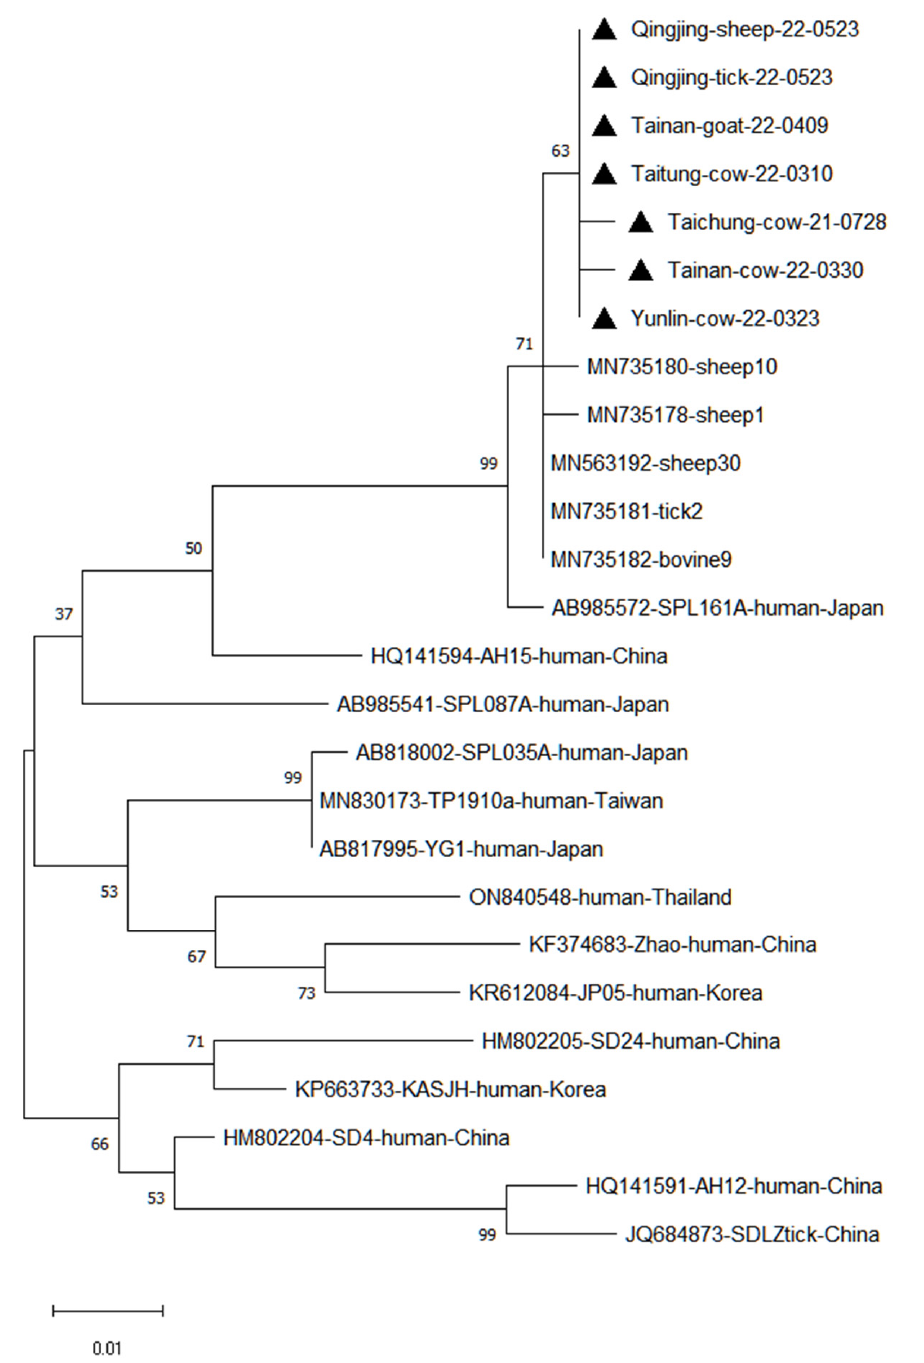
Figure 4. Phylogenetic analysis of the partial S segment of SFTSV identified in Taiwan. In total, sequences of 7 positive samples (indicated as a black triangle) with higher RNA load were ampli- fied and further analyzed. Other representative viral strains were presented with their accession numbers and also the host and country of isolation. The evolutionary history was inferred using the maximum-likelihood method, based on the Kimura 2-parameter model (1000 bootstrap replicates). The percentage of trees in which associated taxa clustered is shown next to the branches. The scale bar indicates nucleotide substitutions per